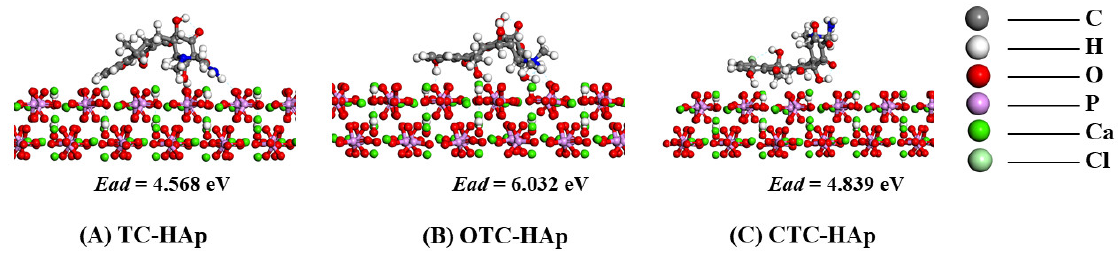
Figure 5. Stable adsorption structures of ( A ) TC, ( B ) OTC, and ( C ) CTC on the HAp surface.